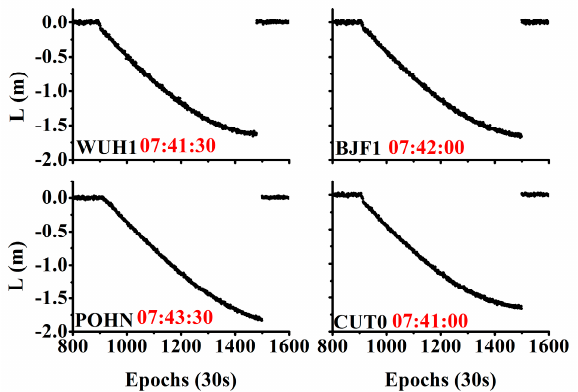
Figure 9. Time series of the array L for satellite C04 at di ff erent stations on 18 July 2016.